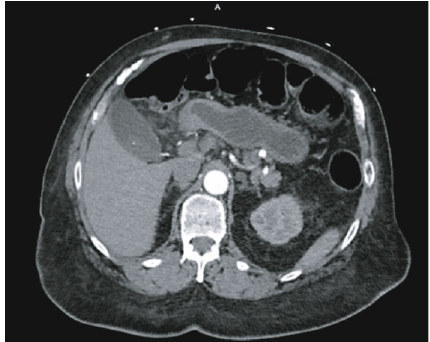
Figure 1: Preoperative CT scan shows mild distention of the gallbladder with gallstones and adjacent in fl ammatory stranding extending to the fi rst and second portion of the duodenum.